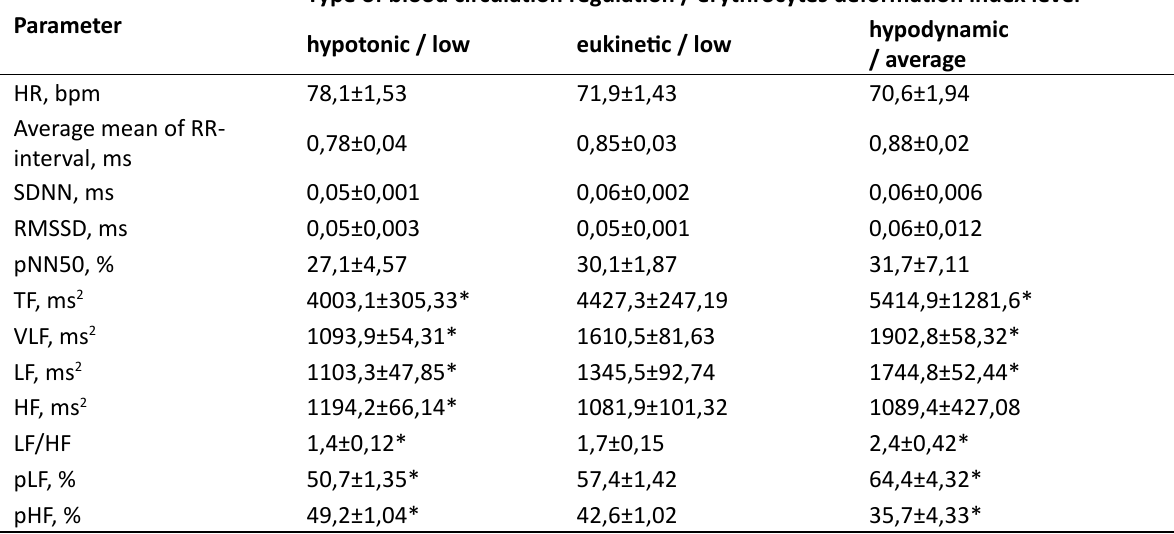
Table 2. Value of heart rate variability parameters of female volleyball players with a different type of blood circulation and value of erythrocytes deformation index before the physical activity of the maximum aerobic productivity (М±SD,